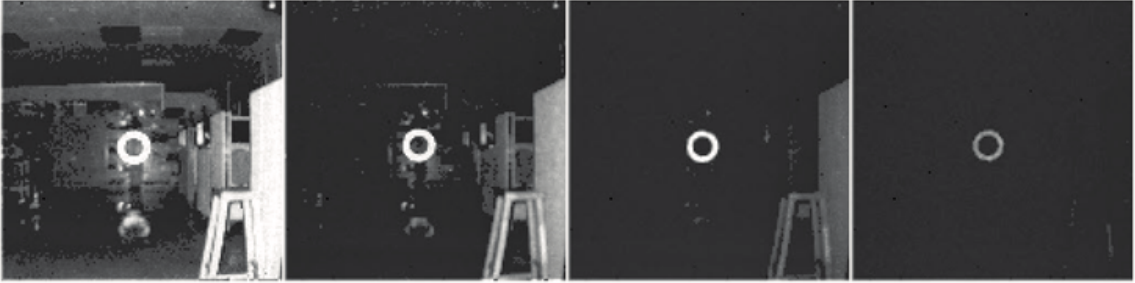
Figure 6. Adjusting camera